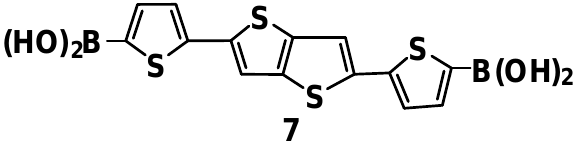
Figure 1. 5,5′-(thieno[3,2-b]thiophene-2,5-diyl)bis(thiophene-5,2-diyl)diboronic acid ( 7